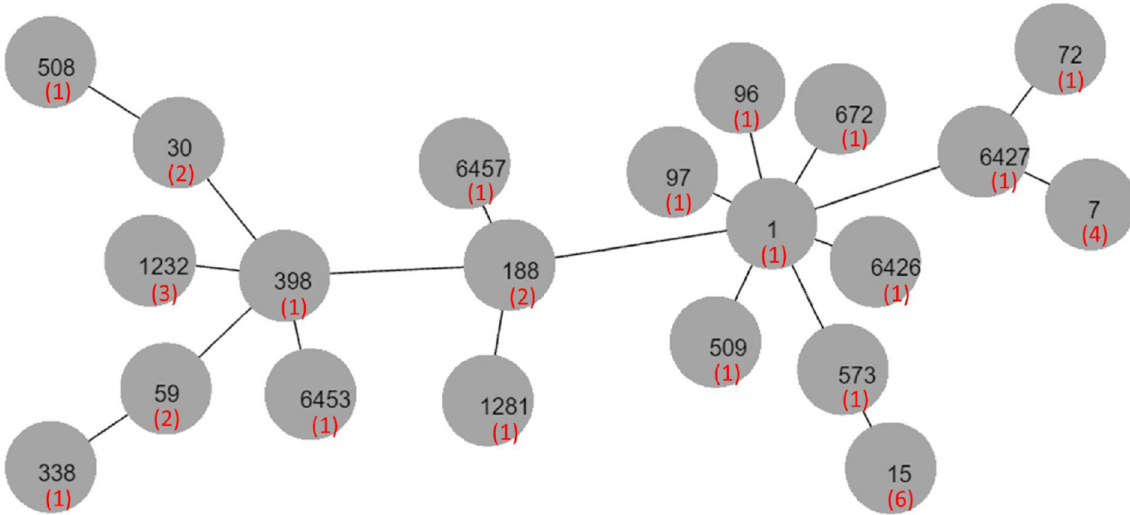
Figure 2. Phylogenic tree of multilocus sequence types of methicillin-susceptible Staphylococcus aureus ocular isolates. Bracketed numbers represent the number of isolates.